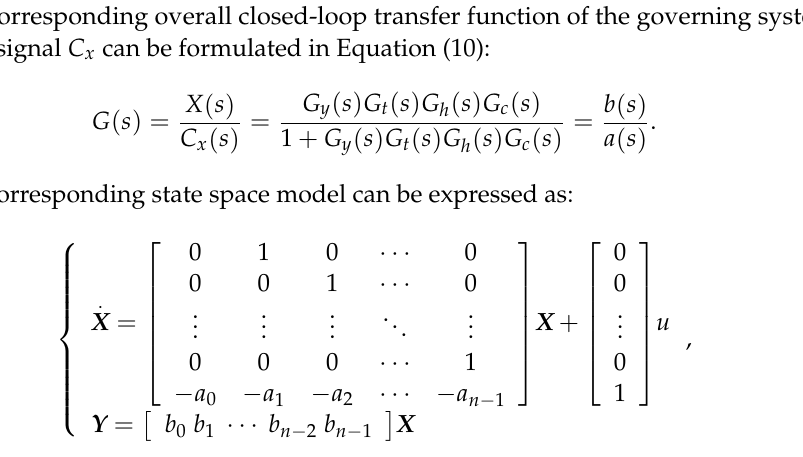
Figure 5. Control block diagram of governing system.